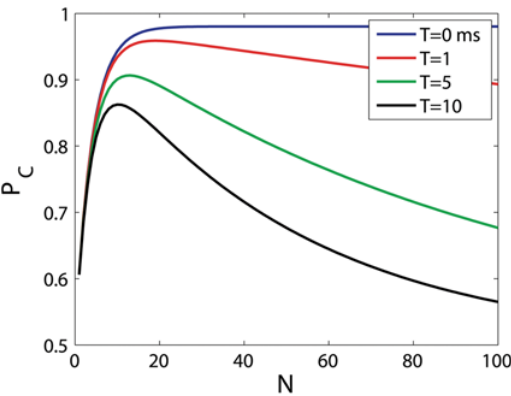
Figure 4. Effect of baseline firing on tWTA readout accuracy. The probability of tWTA correct response, P C , in the case of nonzero baseline firing is shown as a function of the population size, N , equation (24), for T ~ 0,1,5,10 ms from top to bottom. Parameters used for this graph are: t ~ 5 ms , r ~ 50 Hz and r o ~ 1 Hz .